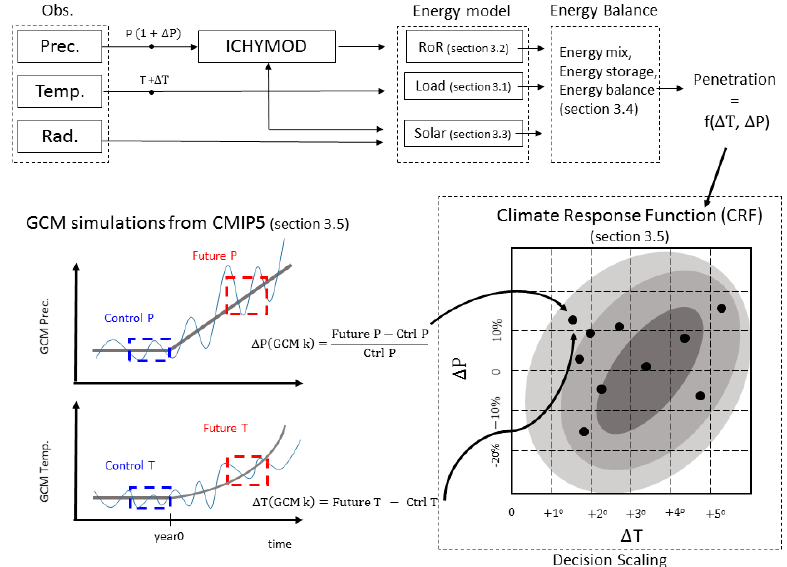
Figure 2. Flow diagram of the analysis framework.